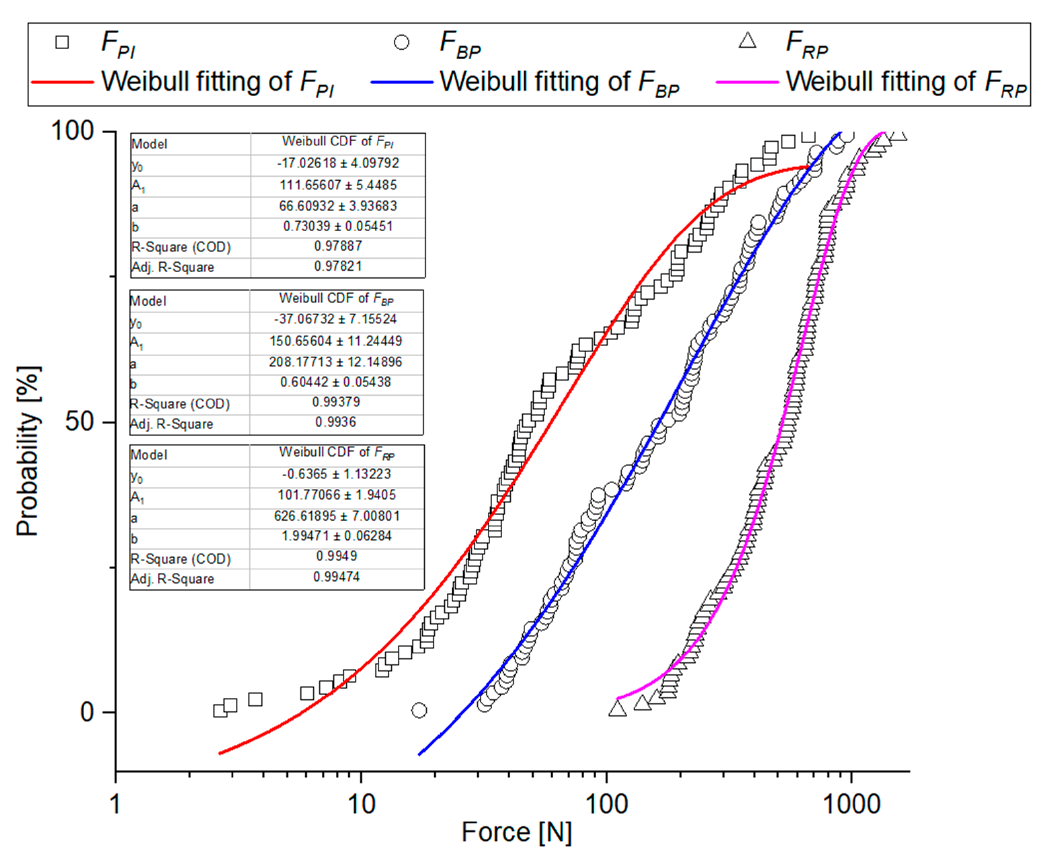
Figure 11. Probability plot distributions fitted to experimental values of forces.